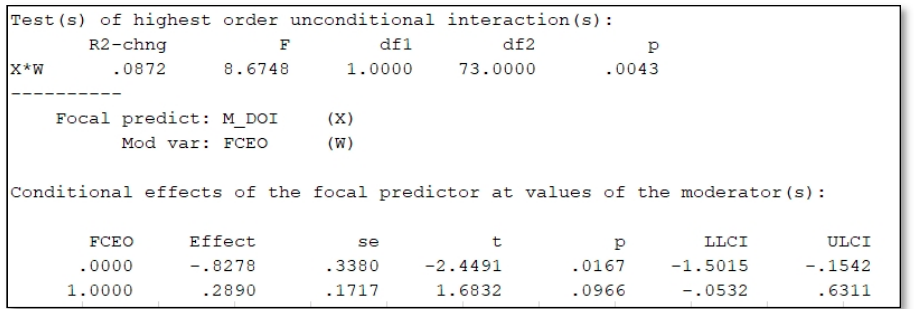
Figure 2. Condition effects of DOI at value of founder CEO (FCEO = 1) and non-founder CEO (FCEO = 0). Output from PROCESS macro for SPSS by Hayes (2012).